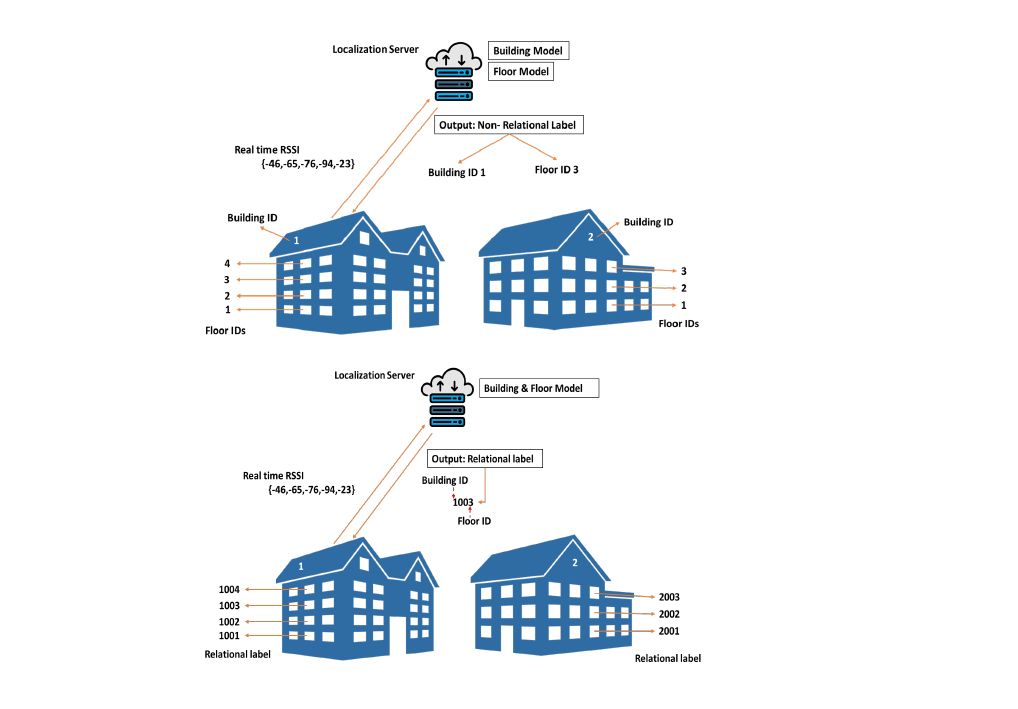
Figure 1. Conventional Conventional non-relational labeling (NRL) [ top ] and proposed relational labeling (RL) [ bottom ] for a multi-building multi-floor environment